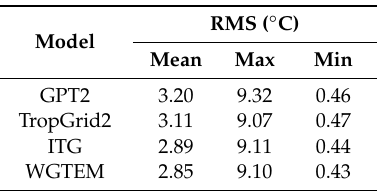
Table 1. Root Mean Square (RMS) of temperature results from di ff erent models validated by European Centre for Medium-range Weather Forecasts (ECMWF)